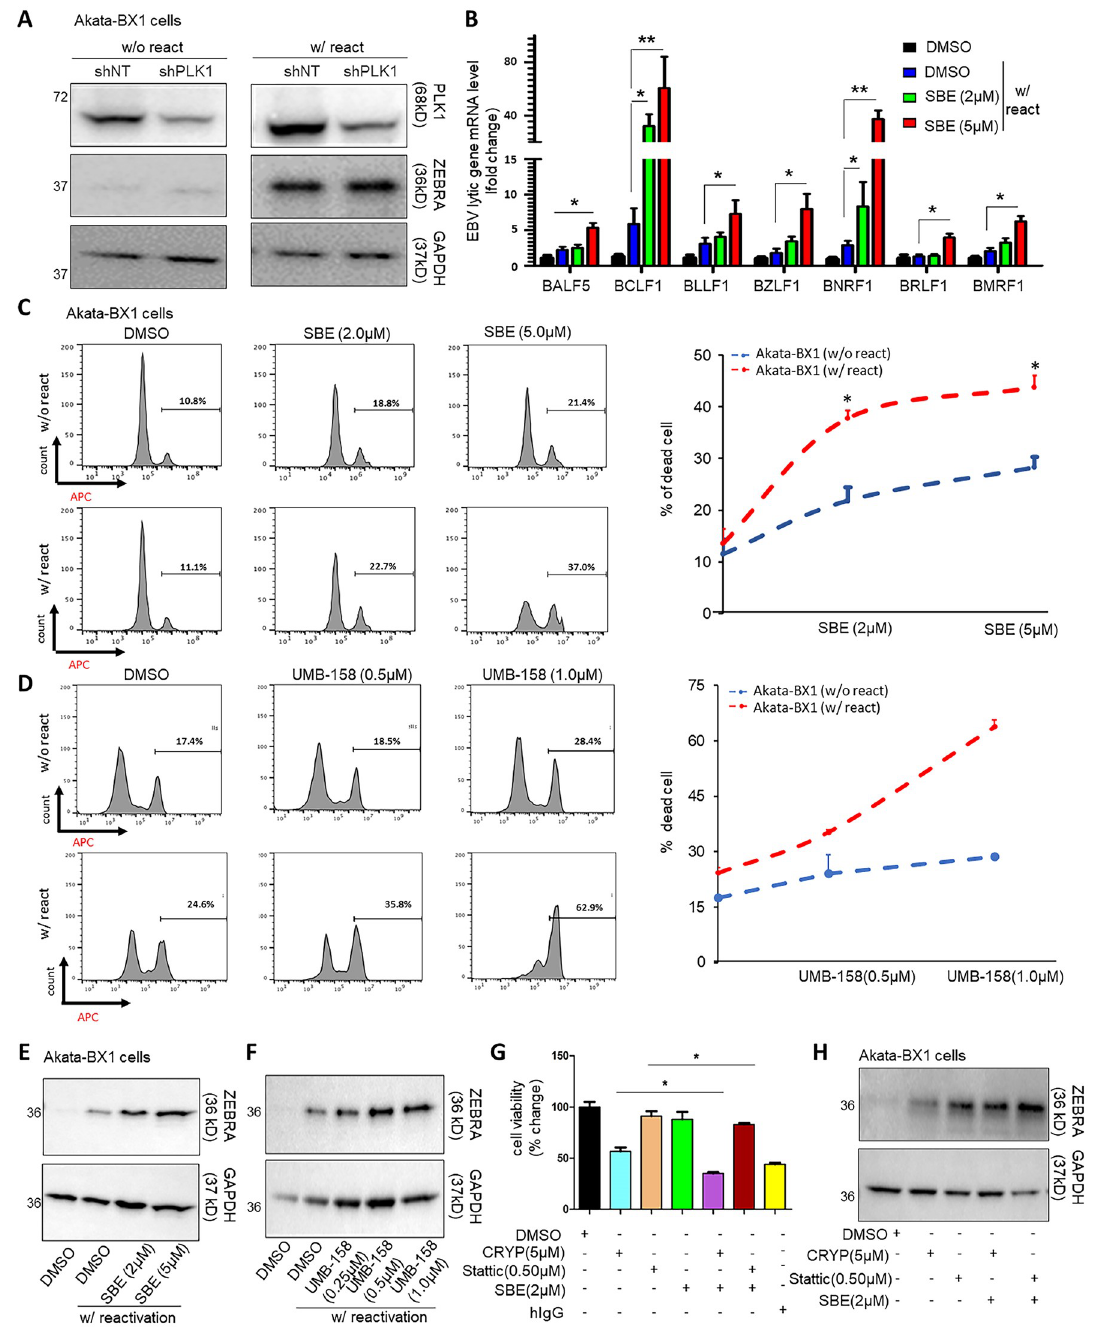
Fig 6. Inhibition of PLK1 benefits EBV reactivation and promotes death of EBV-reactivated tumor cells. (A) Akata-BX1 cells were transiently transfected with the pINDUCER10 vector expressing indicated shRNAs (shNT or shPLK1) using TurboFect transfection reagent, and treated with Dox to induce shRNA expression as well as human IgG (hIgG) to induce EBV reactivation. Protein level of PLK1 and EBV lytic gene ZEBRA was measured by immunoblotting. GAPDH was used as a loading control. (B) mRNA level of indicated EBV lytic genes was measured by RT-qPCR and normalized to GAPDH. Results were calculated from n = 3 independent experiments and presented as mean ± SD ( � p < 0.05, �� p < 0.01; two-way ANOVA). (C, D) Akata-BX1 cells were treated with SBE (C), UMB-158 (D), or DMSO, in the presence or absence of hIgG. Percentage of dead cells was measured by LIVE/DEAD staining, followed by flow cytometry analysis. (E, F) Protein level of EBV ZEBRA in above cells (C, D) was measured by immunoblotting. GAPDH was used as a loading control. (G) Akata-BX1 cells were treated with CRYP or stattic in the presence or absence of SBE. hIgG treatment was used as a positive control to reactivate latent EBV. Cell viability of these cells was measured by ATP-based assays and normalized to DMSO. (H) Protein level of EBV ZEBRA in above cells (G) was measured by immunoblotting. GAPDH was used as a loading control.